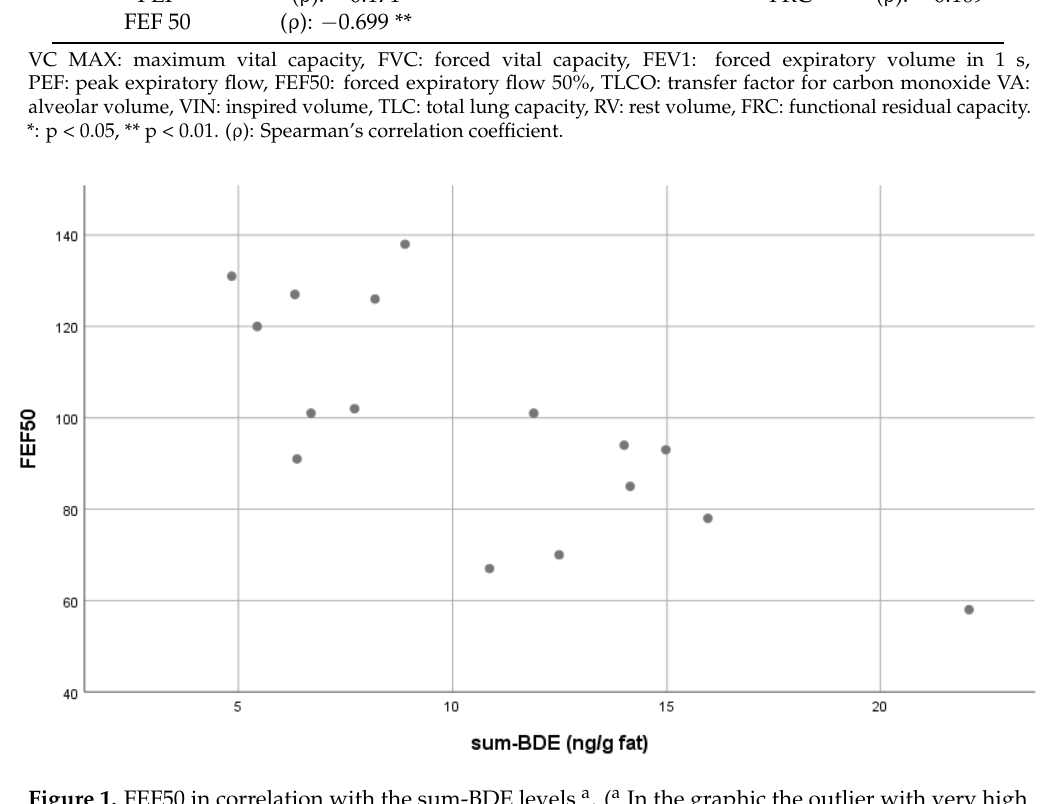
Figure 1. FEF50 in correlation with the sum-BDE levels a . ( a In the graphic the outlier with very high BDE levels was